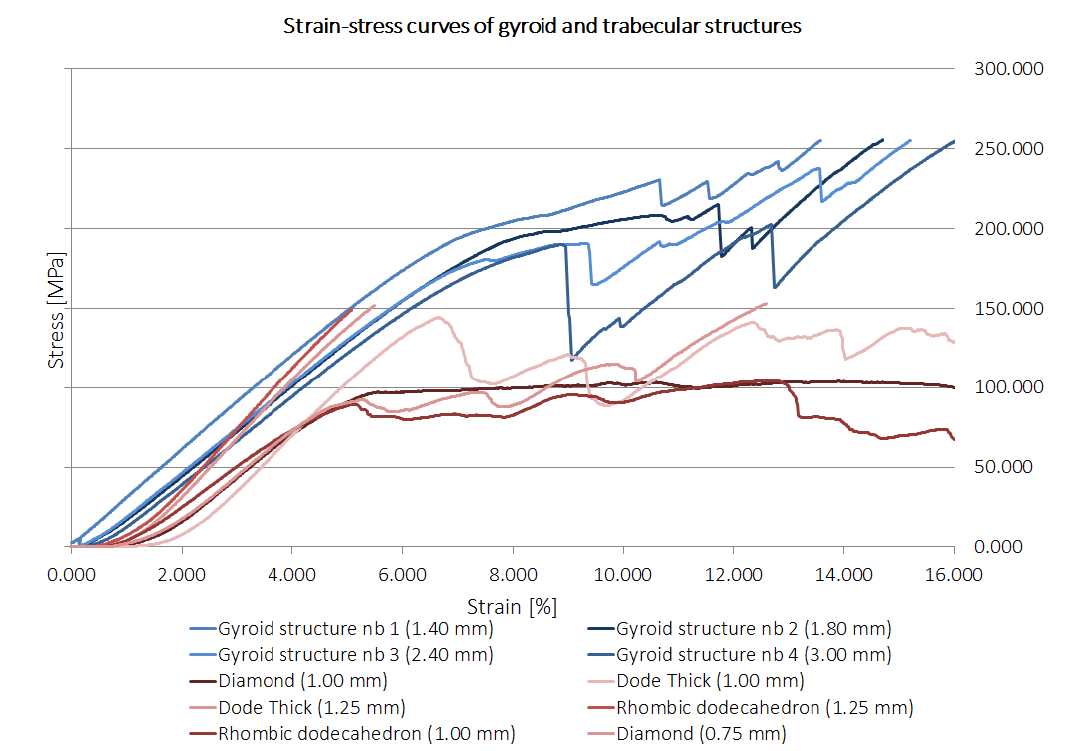
Figure 3. The overview of the stress-strain curves of trabecular and gyroid structures. We can see quite similar elastic modulus but significantly different compressive